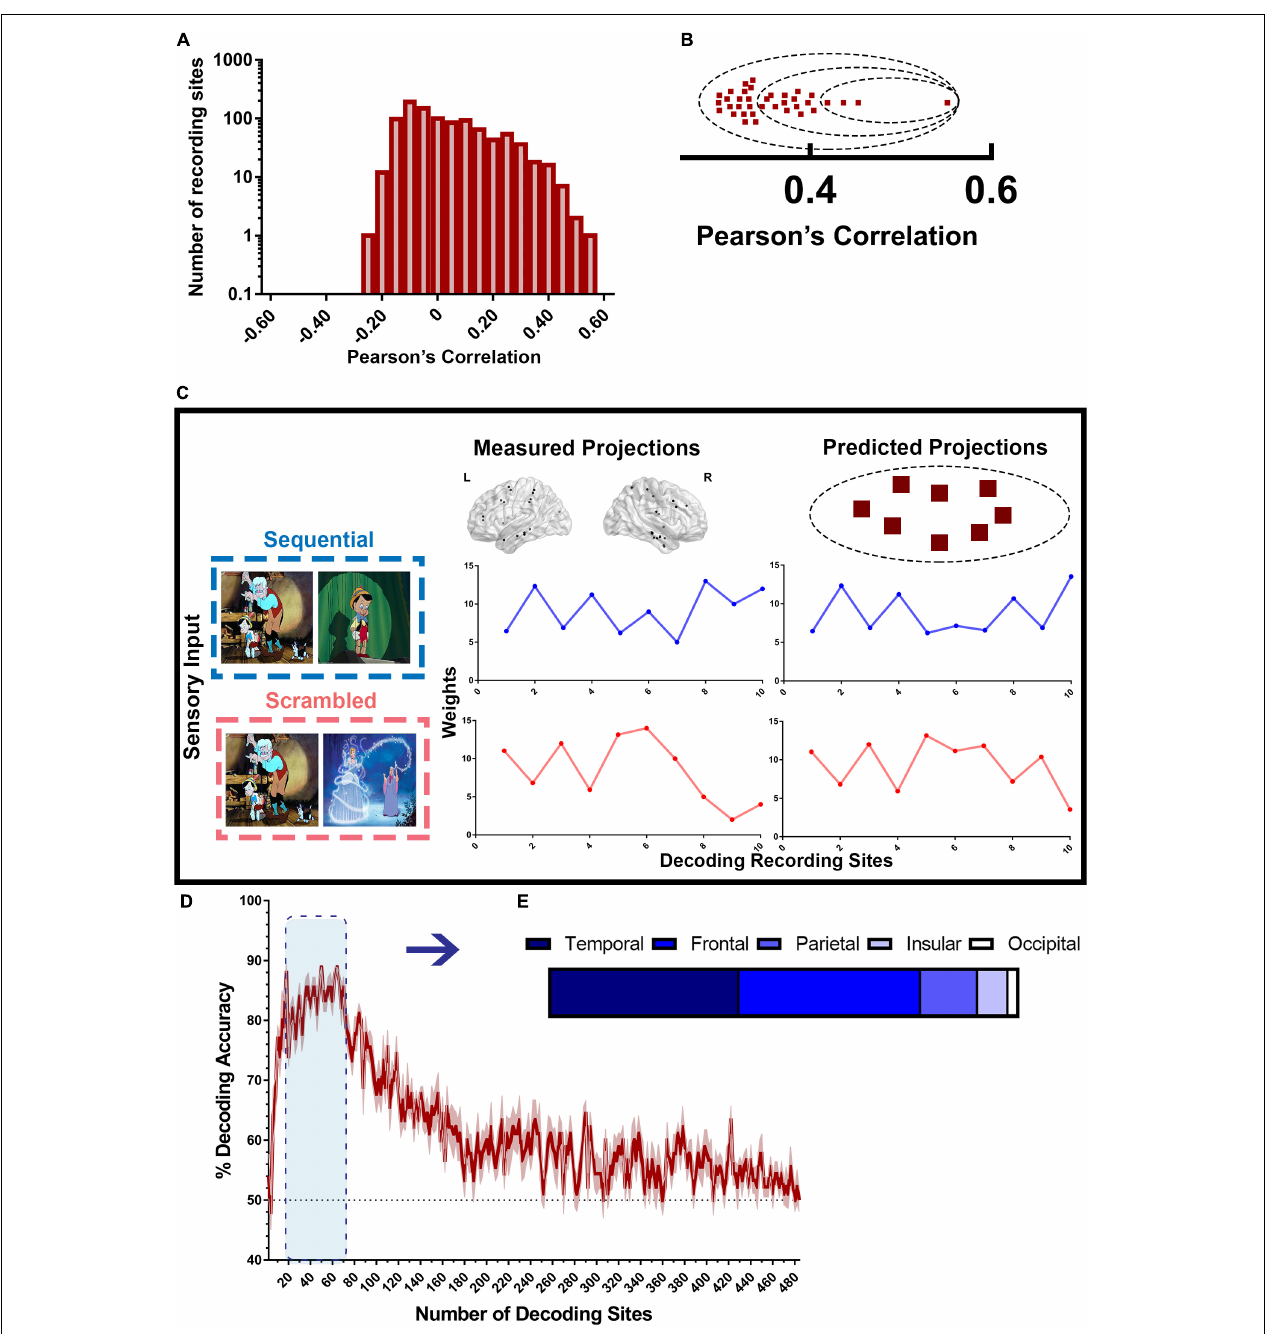
FIGURE 6 | Decoding model for scrambled and sequential patterns. (A) Distribution of recording sites ordered by encoding accuracy as shown in Figure 4 used by the decoding model. (B) High encoding performance recording sites (red squares) are sorted based on their accuracy from the highest encoding performance to the lowest, then assigned to groups of increasing sizes n (dashed circles), containing the n highest encoding performance sites. Then, a random subset of half the size of the selected group of sites is used in every iteration of the decoding model. (C) illustrates how the decoding model works. To decode the type of narrative from the measured projections, the encoding model for each recording site in the studied group was used to generate “predicted patterns” (right) corresponding to each of the two types of experimental conditions. The set of measured projections from a subset of 10 recording sites from both Scr (red) and Seq (blue) is compared to the predicted projections for each stimulus from the same sites. Each of the two predicted patterns was then correlated with the measured pattern. If the predicted pattern corresponding to the correct stimulus type had the highest correlation with the measured pattern, decoding is considered successful for that single trial. (D) Decoding accuracy of Scr vs. Seq conditions using broadband spectral pattern of various sizes and subsets of sites. The accuracy (mean ± SEM) for varying size of groups of sites is shown. The dashed black line represents random chance (50%). (E) Distribution of sites with the highest decoding accuracy across brain